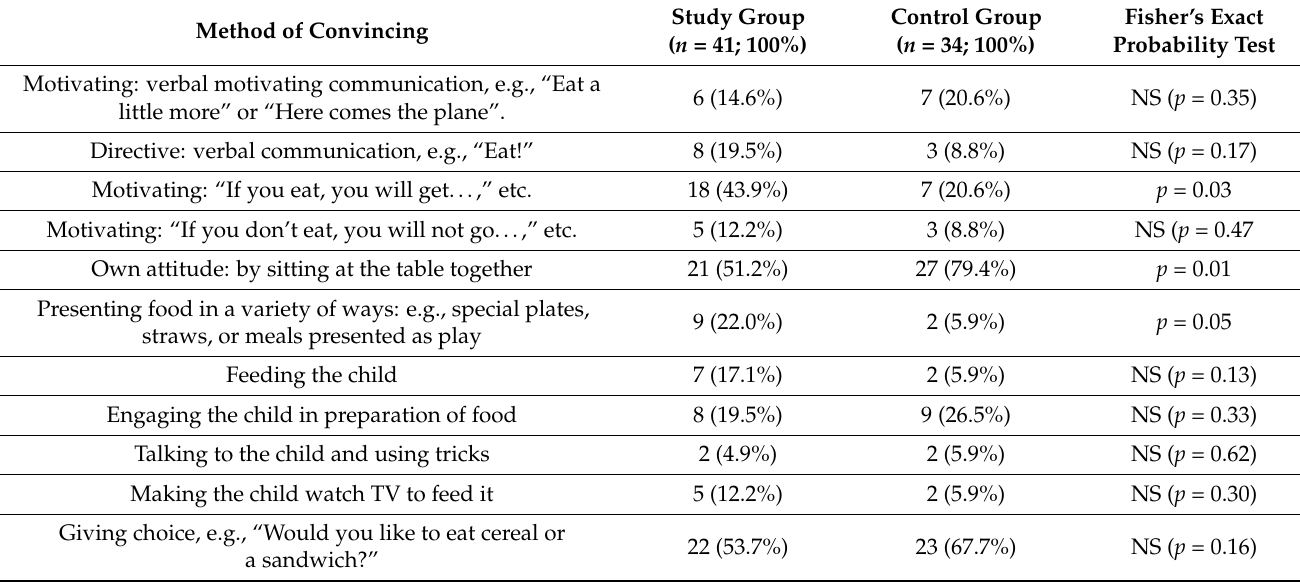
Table 14. The method of convincing child in the Study Group and Control Group to eat (question A/9). Method of Convincing